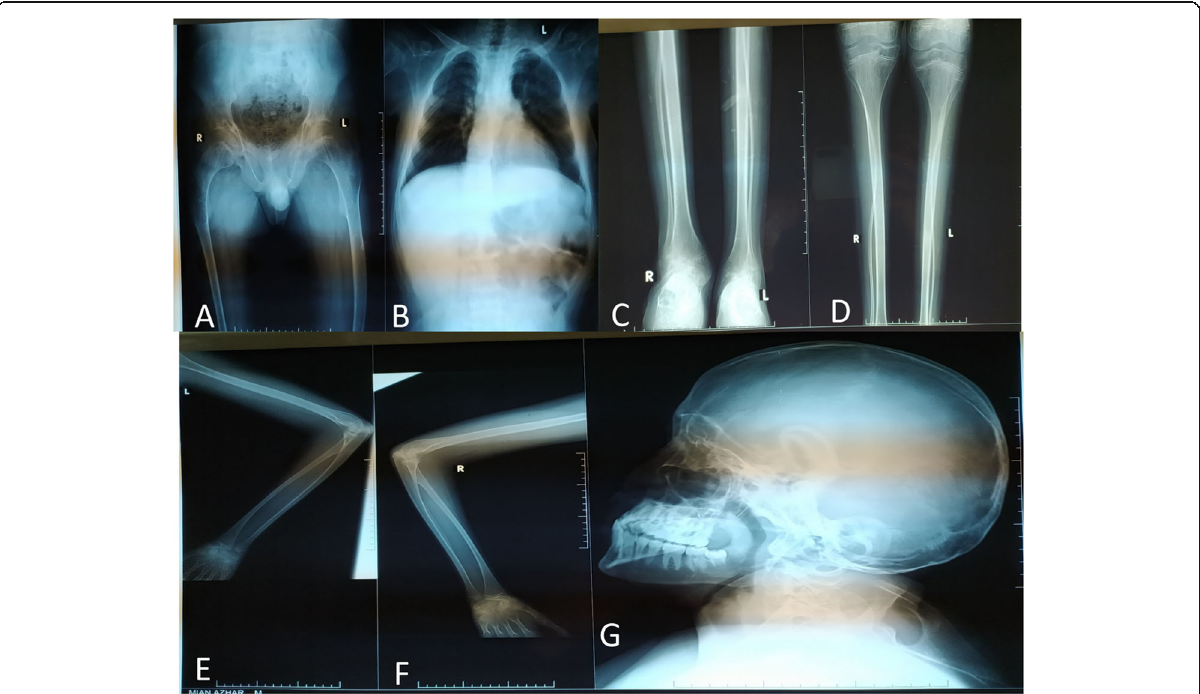
Fig. 4 Radiographic findings in Patient VI:3. a . Frontal radiograph of the pelvis shows increased bone density, trabecular thickening and ossification of the sacrotuberous ligament. Mild flattening of the acetabular roof is noted giving rise to champagne glass deformity of the pelvis. b Both lung fields are clear Bilateral CP angles are sharp. Mediastinal contours appear unremarkable. Scoliotic deformity of the spine is noted with convexity towards right side. c Outward bowing of bilateral femur is noted. d Bilateral fibula shows marked thinning and outward bowing ( e , f ) outward bowing of bilateral humerus bone is also noted. g Long oval face hypoplasia and bone